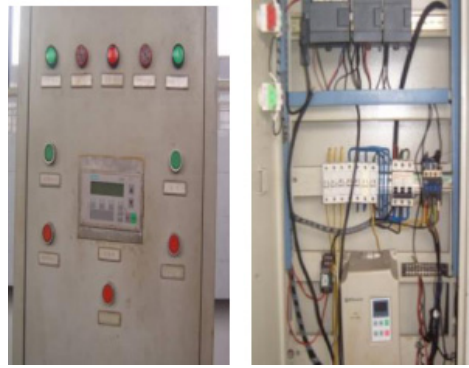
Figure 11. Electric control cabinet.